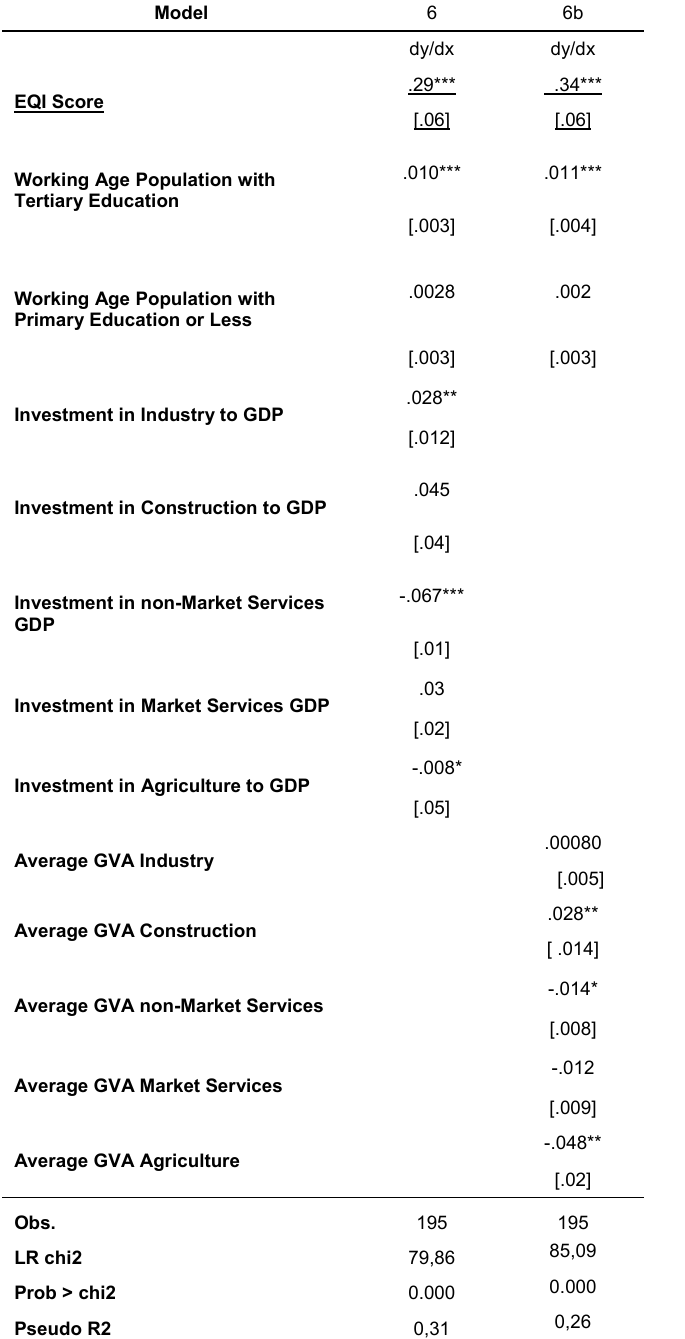
Table 6. Marginal effects on probability Y=1|X. Group A – robustness